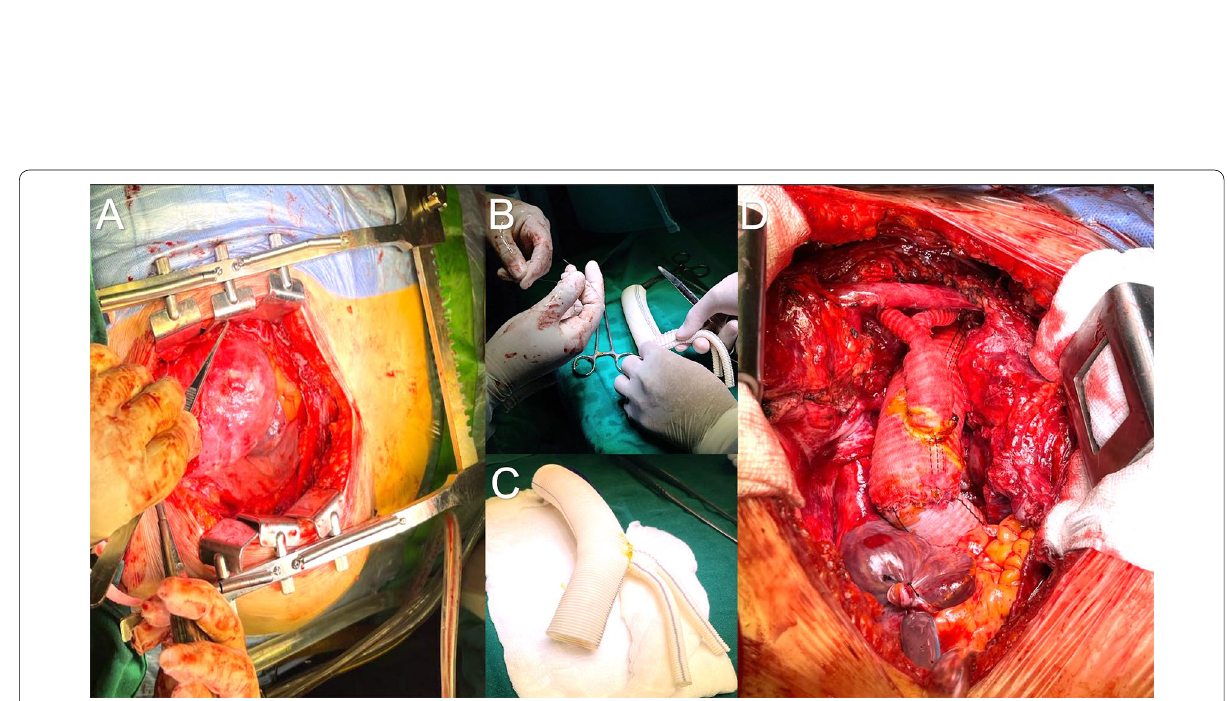
Fig. 3 Intraoperative views A ATAA by median sternotomy approach. B, C Table construction of aortic arch graft. D Bentall Surgery Arch Replacement with Supra‑Aortic Vessel